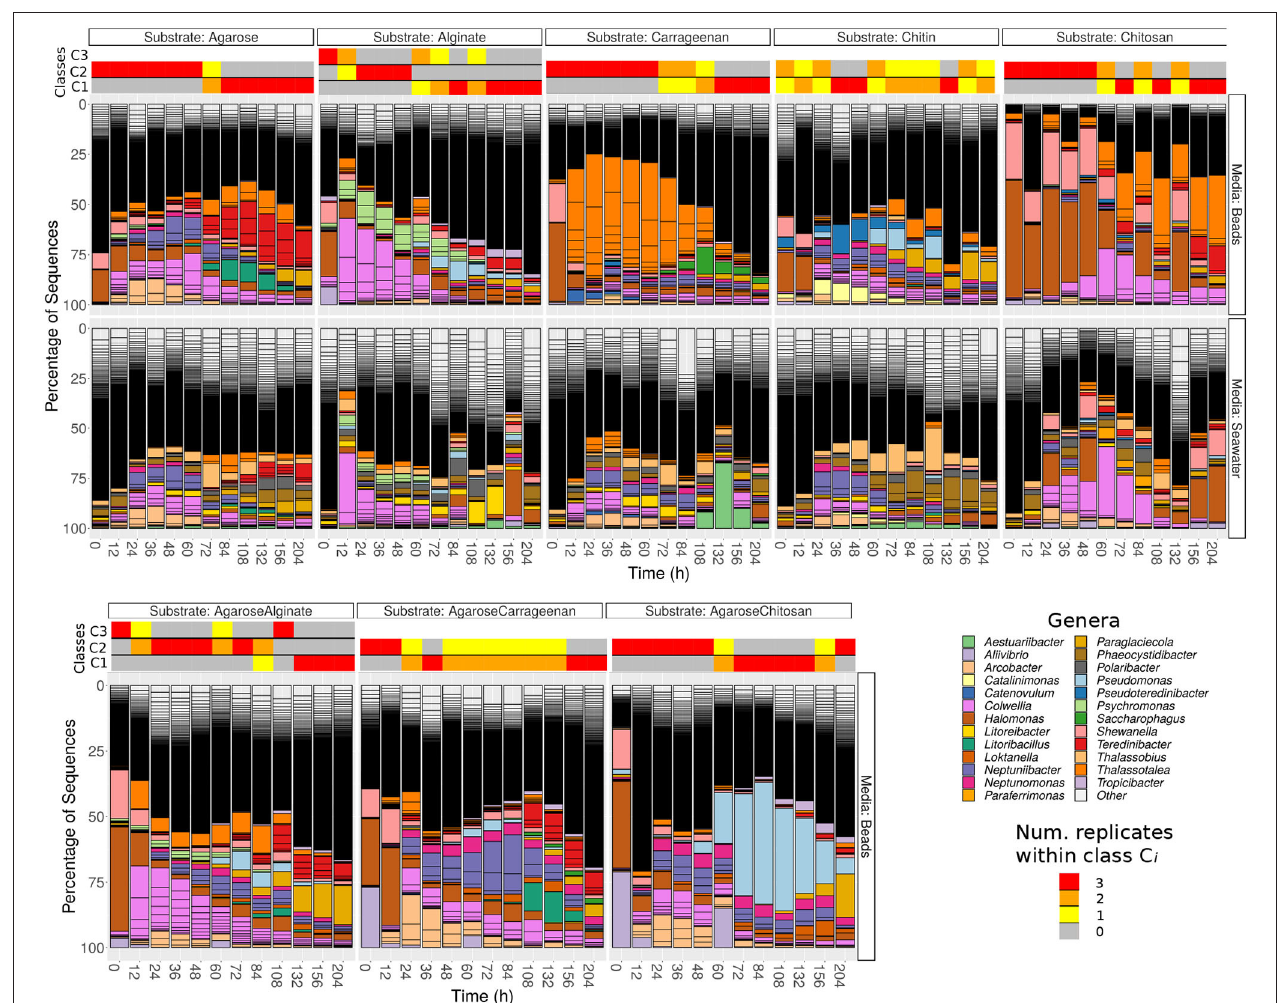
FIGURE 1 | Relative abundances of Exact Sequence Variants (ESVs) for populations attached to beads made of pure substrates (first row) and present in the surrounding water (second row) for each substrate (columns) at the different time points. The third row represents the population dynamics of beads made of mixed substrates. Contiguous sections with the same color in a given bar represent different ESVs belonging to the same genera. Highlighted genera are those among the 20 most abundant on any of the substrates. The remainder ESVs are classified as “other”, and their small relative abundance leads to a black “continuum”. In the beads experiments, the horizontal bars on the top of the bar plots represent the classes obtained with unsupervised clustering, and the color represents the number of replicates assigned to the different classes at each time